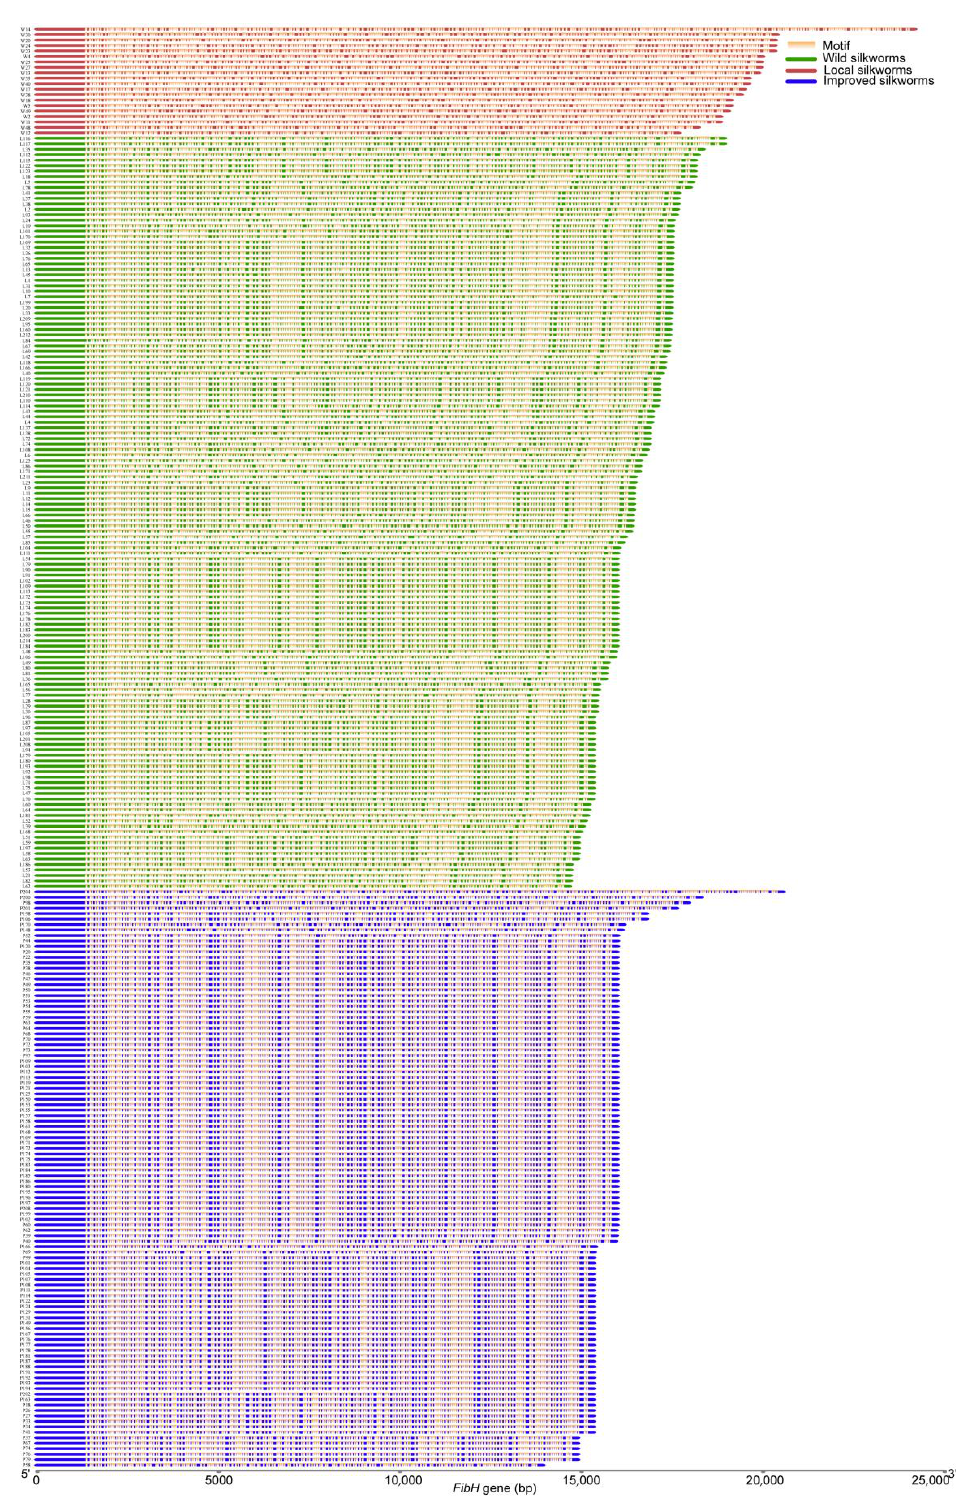
Figure 2. FibH gene complete sequences (FibHome) of 264 silkworms from the pan-genome. All FibH sequences were unaligned and arranged by length. Motif, orange; Wild silkworms, red; Local silkworms, green; Improved silkworms, blue.